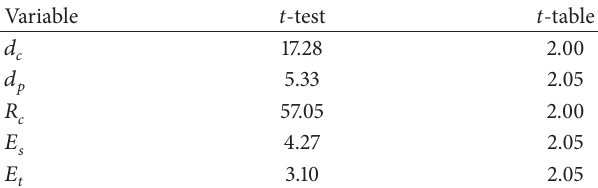
Table 4: Results of the 𝑡 -test for the evaluated correlations.